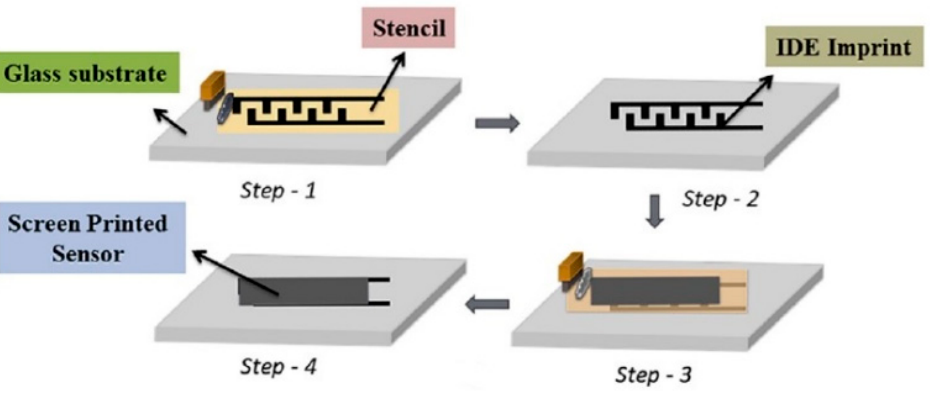
Figure 21. Screen-printing process [87].